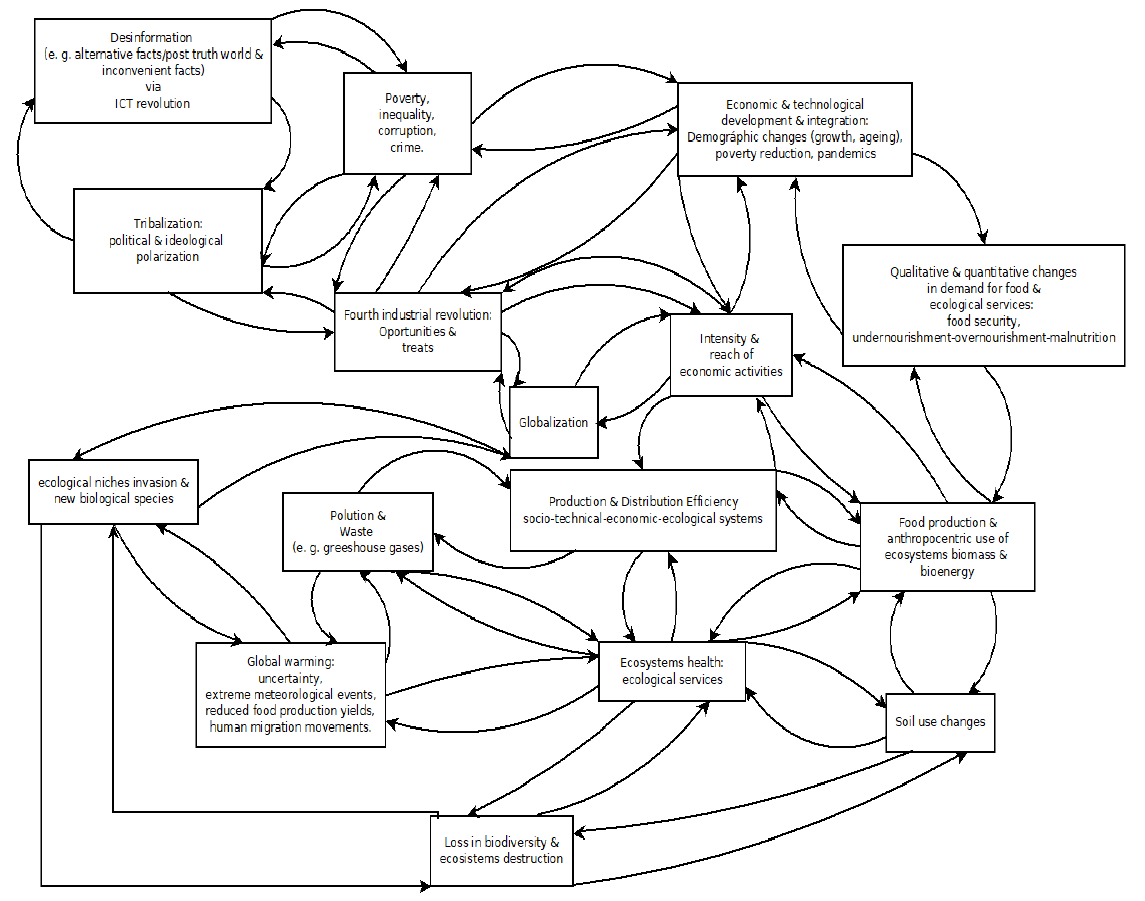
Figure 1. Some of the state variables and functional couplings related to sustainable human-made complex systems.